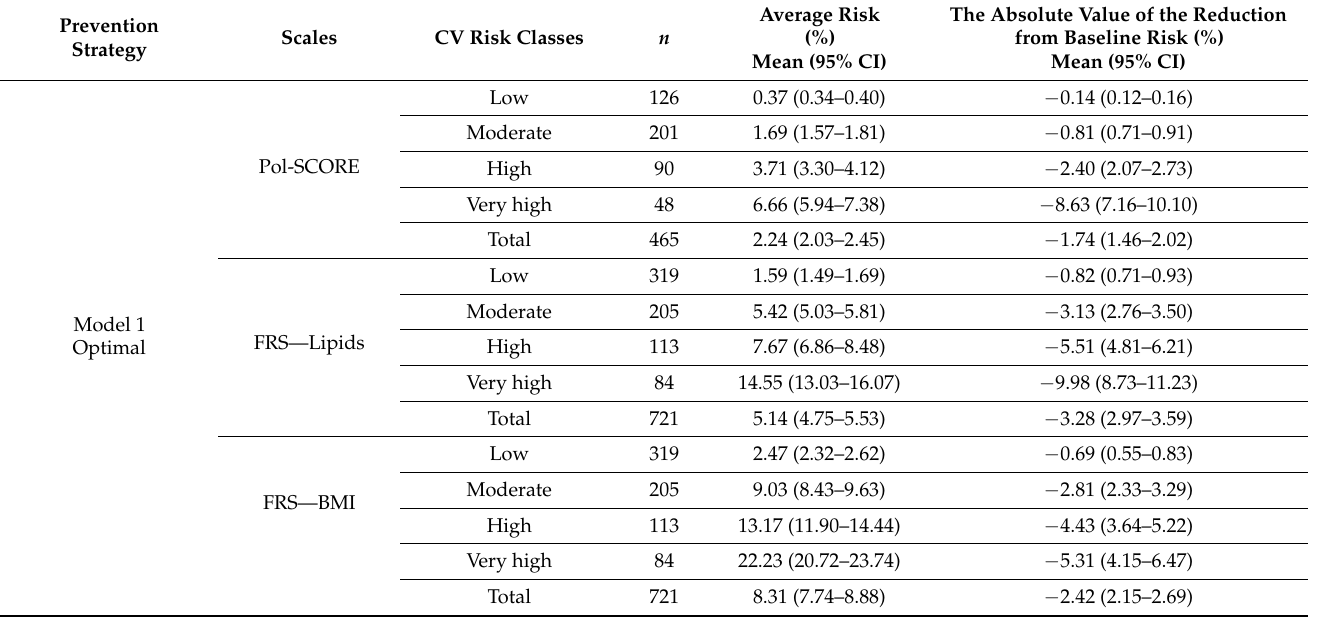
Table 3. Estimation of the effects of particular prevention models on 10-year risk of fatal CVD (Pol-SCORE); 10-year risk of developing the first CVD event (Framingham Cardiovascular Disease); and 10-year risk or life risk of MI, stroke, or CV death (lifetime-perspective model for individual- izing cardiovascular disease prevention strategies in apparently healthy people LIFE-CVD) in the appropriate study